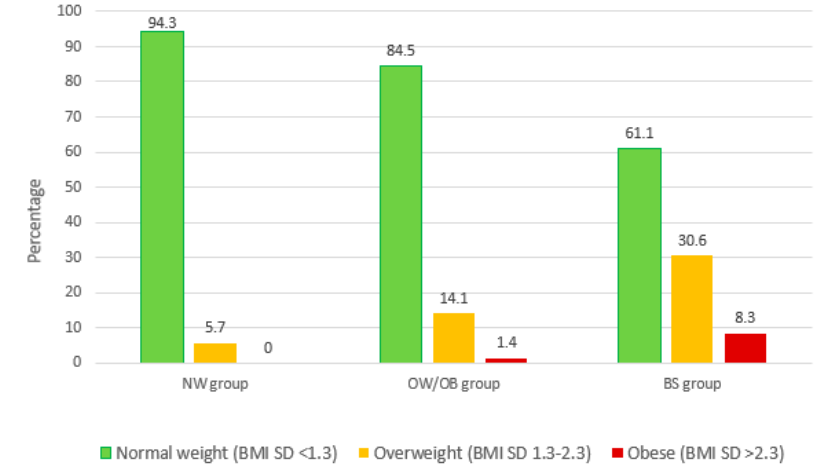
Figure 1. Prevalence of weight categories for the children, based on the maternal groups.